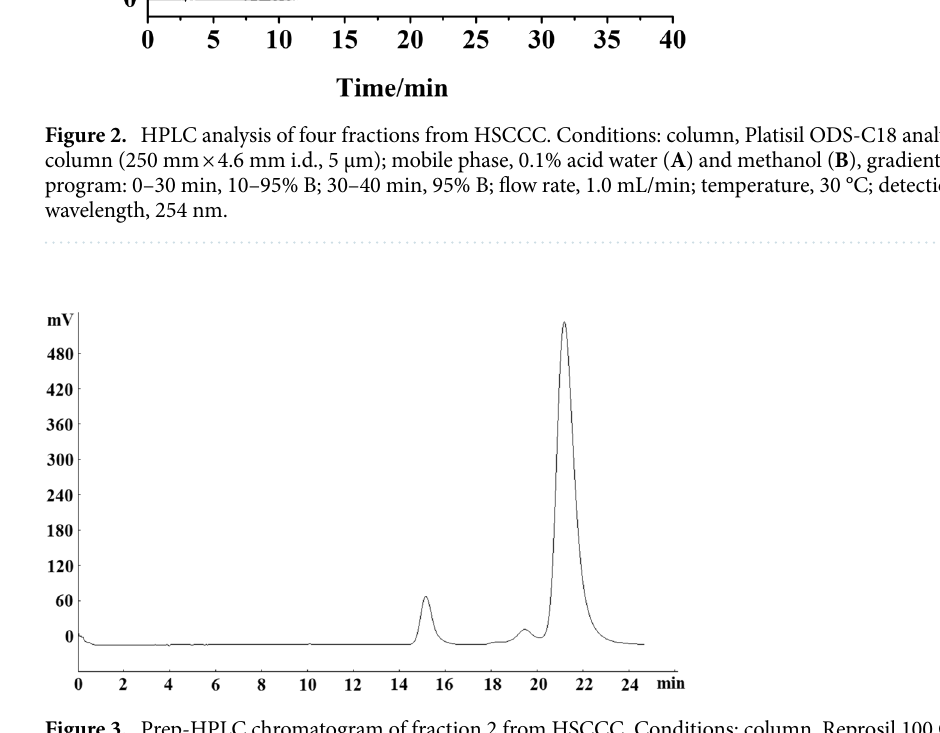
Figure 3. Prep-HPLC chromatogram of fraction 2 from HSCCC. Conditions: column, Reprosil 100 C18 column (250 × 20 mm i.d., 10 μm); mobile phase, 40% methanol; flow rate, 18 mL/min; detection wavelength, 254